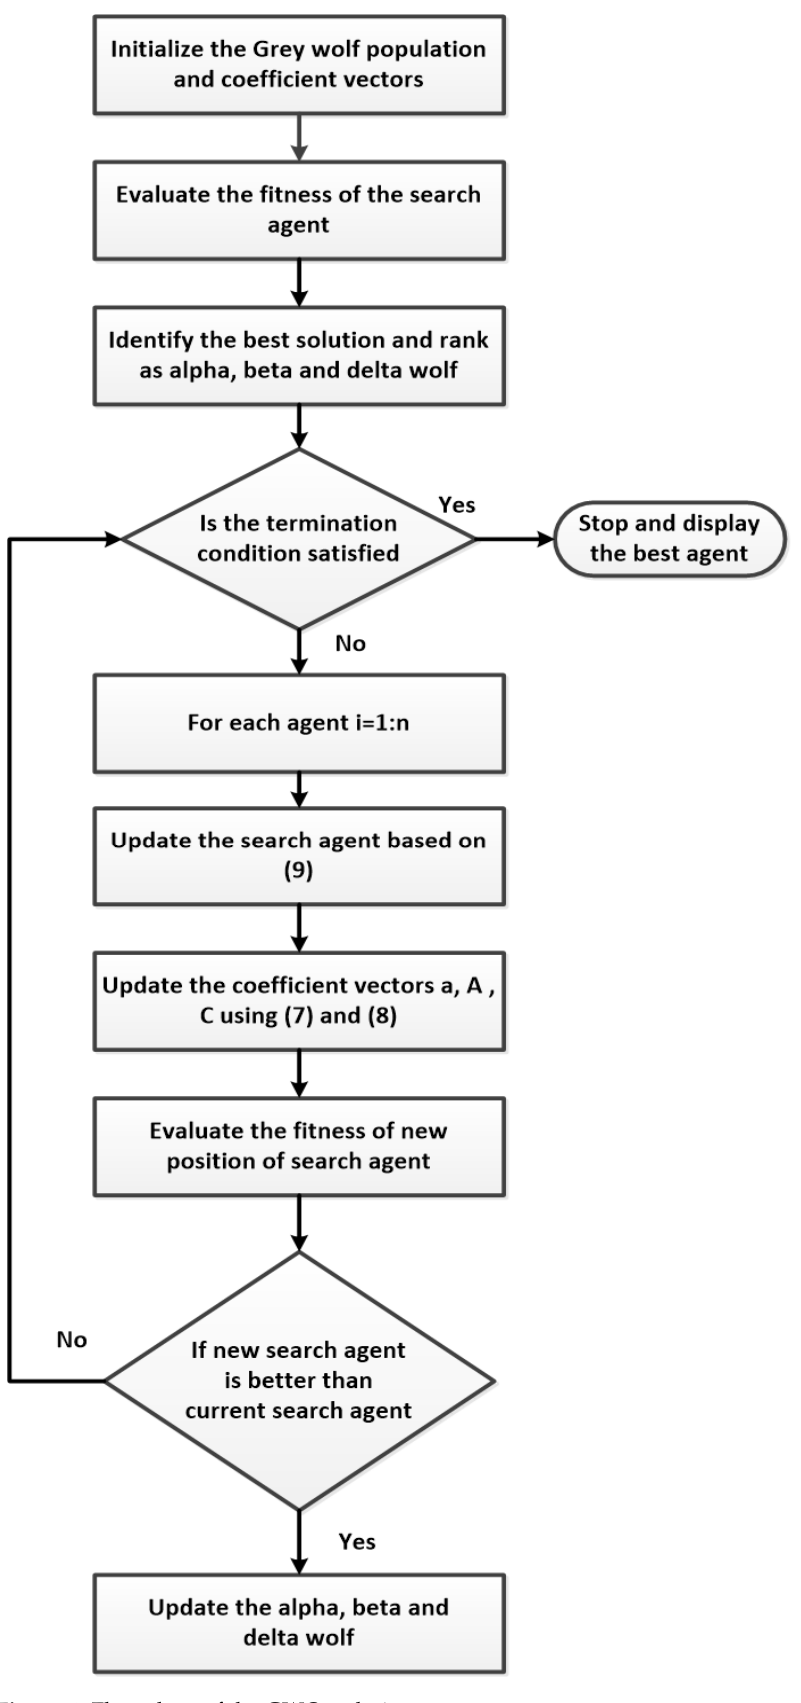
Figure 4. Flow chart of the GWO